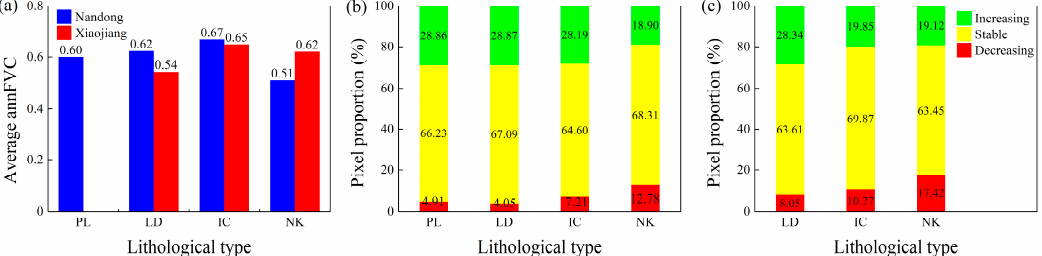
Figure 9. ( a ) Comparison of average annFVC under different lithological settings in the karst watersheds of Nandong and Xiaojiang during the study period of 1988–2016; and the pixel proportion of vegetation trends under different lithological attributes in: ( b ) Nandong; and ( c ) Xiaojiang watersheds. Main lithological attributes include PL (pure limestone), LD (limestone and dolomite interbedded layer), IC (impure carbonate rocks), and NK (non-karst rocks).